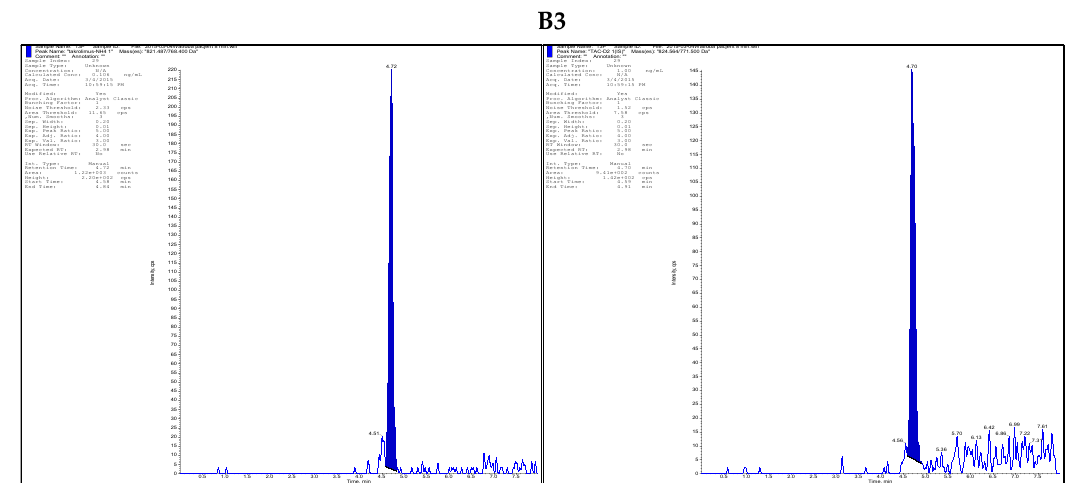
Figure 1. Representative multiple reaction monitoring chromatograms of ( A1 ) blank kidney tissue sample without TAC and I.S. ( A2 ) Tissue kidney sample containing 10 pg/mg of TAC (LOQ) with Tac 13 C-d2 (I.S.) ( A3 ) Kidney tissue obtained from a patient administered with Prograf, with a measured Tac concentration of 65.1 pg/mg coeluted at 4.68 min denoted with Tac 13 C-d2 and ( B1 ) blank liver tissue sample without TAC and I.S. ( B2 ) Tissue liver sample containing 10 pg/mg of TAC (LOQ) with Tac 13 C-d2 (I.S.) ( B3 ) A liver tissue sample obtained from a patient administered Prograf, with a measured Tac concentration of 151.4 pg/mg coeluted at 4.68 min denoted with Tac 13 C-d2.